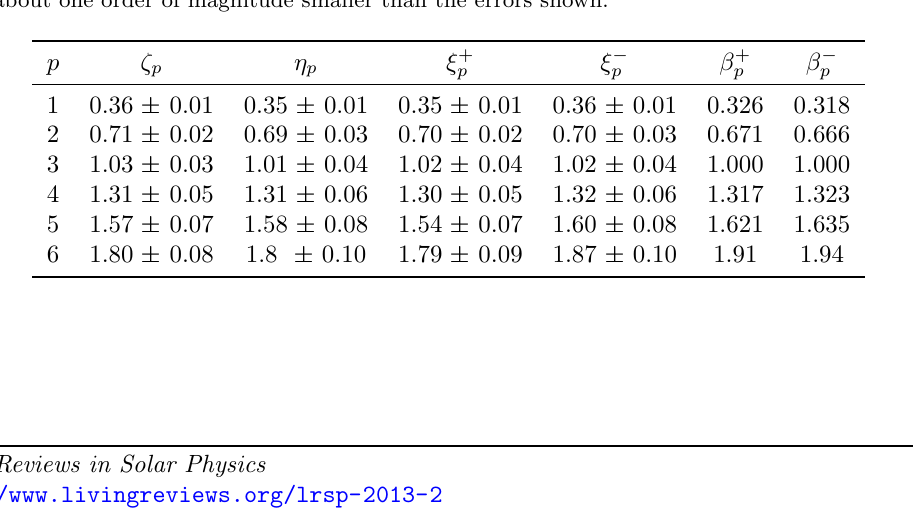
Table 4: Scaling exponents for velocity and magnetic variables, Els¨asser variables, and fluxes. Errors on 𝛽 ± 𝑝 are about one order of magnitude smaller than the errors